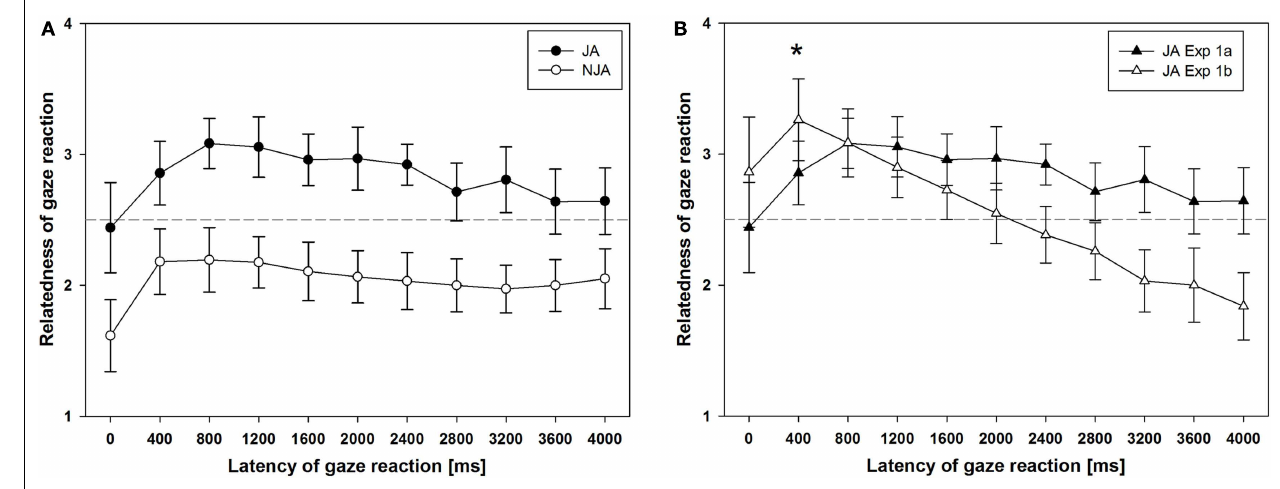
in JA, only the latency of the gaze reaction is varied. For better comparability, the joint attention data of Experiment 1a (JA in the context of NJA as another option to act) are plotted together with the data from Experiment 1b (JA